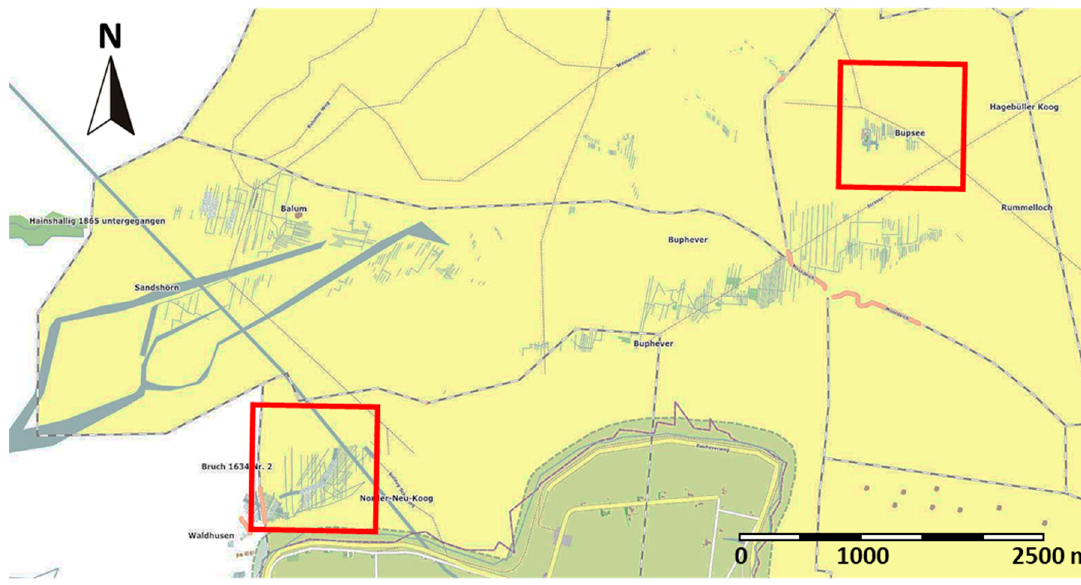
Figure 14. Detail of the map shown in Figure 4. Two red squares denote the locations of the SAR images shown in Figure 6 and in Figure 9, respectively. Map: C.